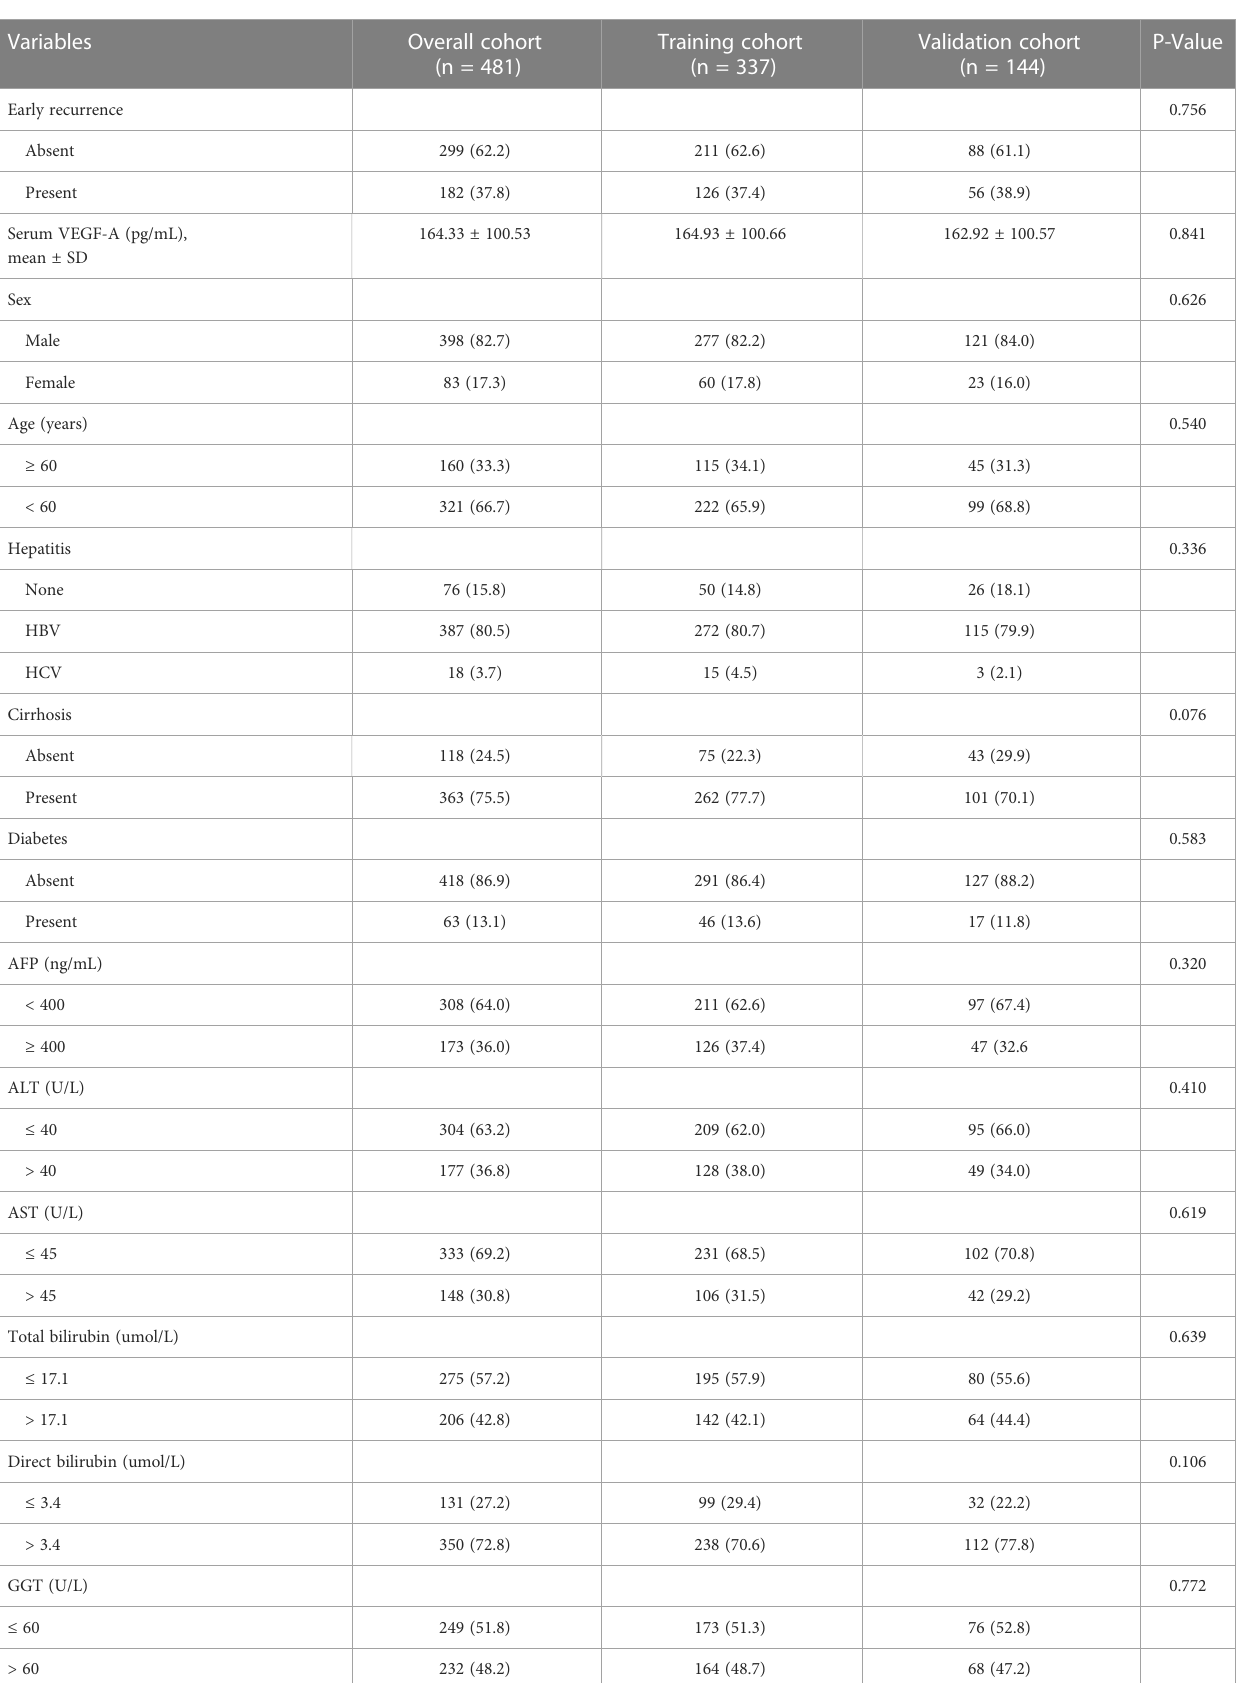
TABLE 1 Demographic, clinical, pathological and imaging characteristics of HCC patients in the training and validation